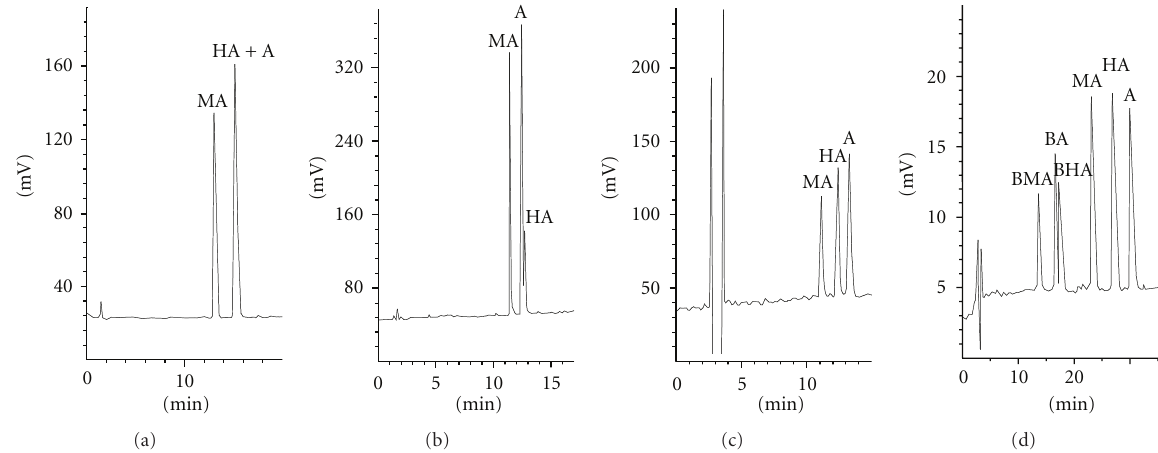
Figure 1: HPLC chromatograms of aconitine (A), mesaconitine (MA), hypaconitine (HA), and their corresponding semi-hydrolyzed products benzoylaconitine (BA), benzoylmesaconitine (BMA), and benzoylhypaconitine (BHA) in di ff erent gradient programs (a)–(d) (see